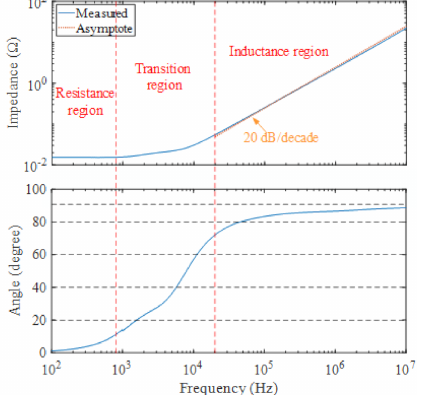
Figure 4. Short circuit (SC) impedance of the 0.67 m cable in DM.